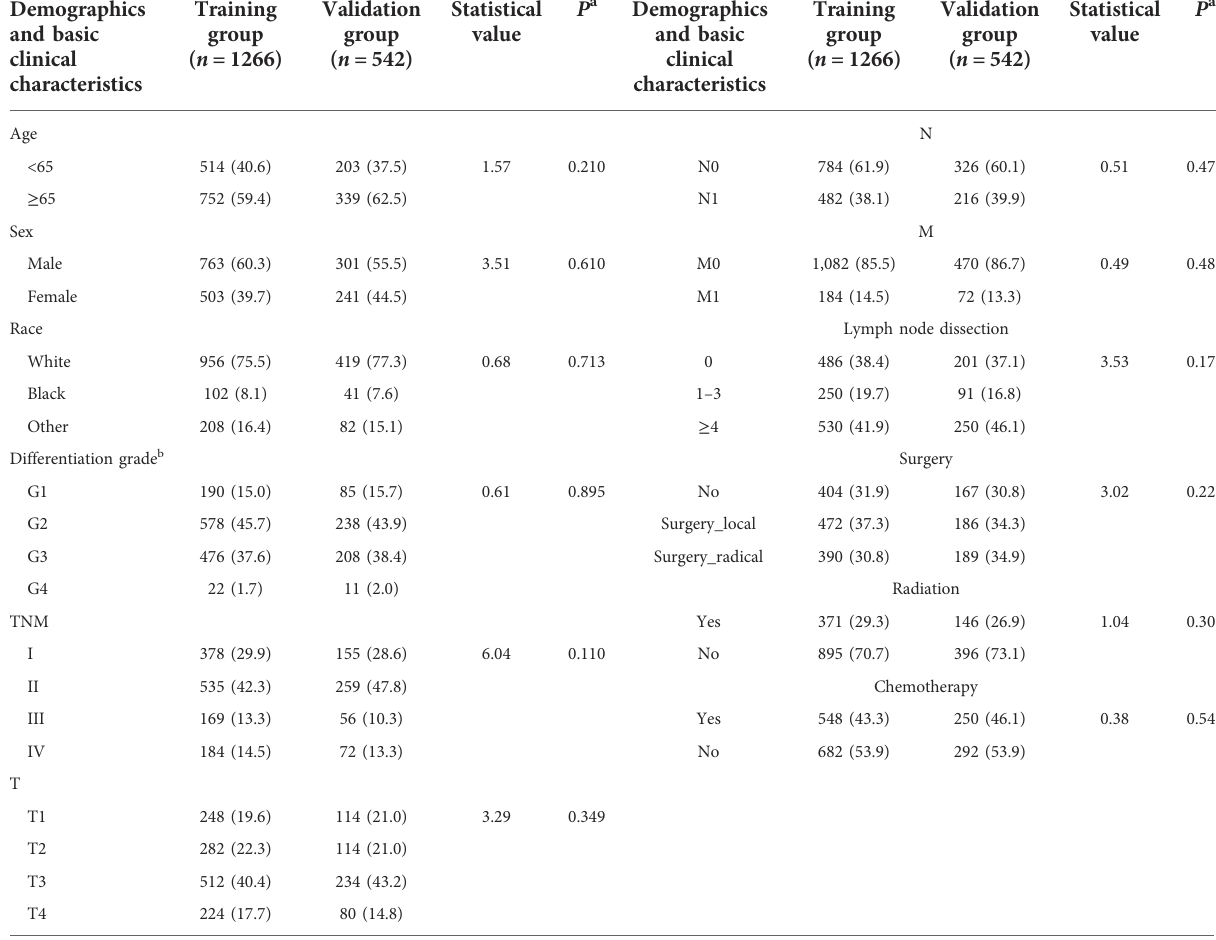
TABLE 1 Baseline demographic and basic clinical characteristics of patients with pCCA